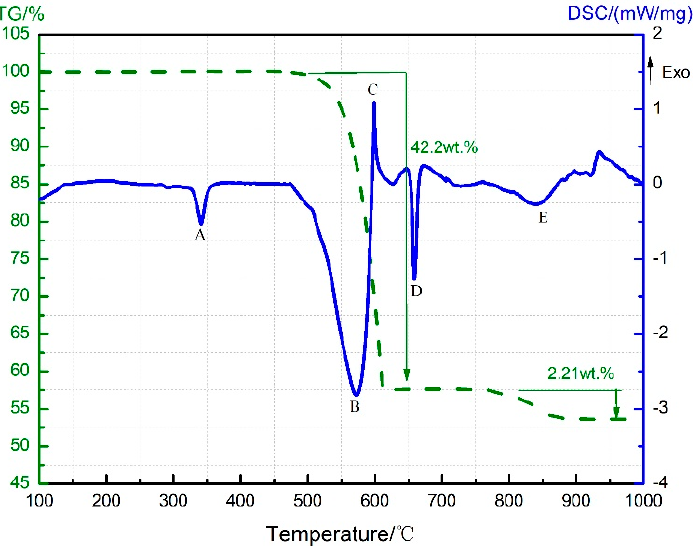
Figure 1. Thermogravimetry-differential scanning calorimetry (TG-DSC) curve of the PTFE/Al (polytetrafluoroethylene/aluminum) sample.